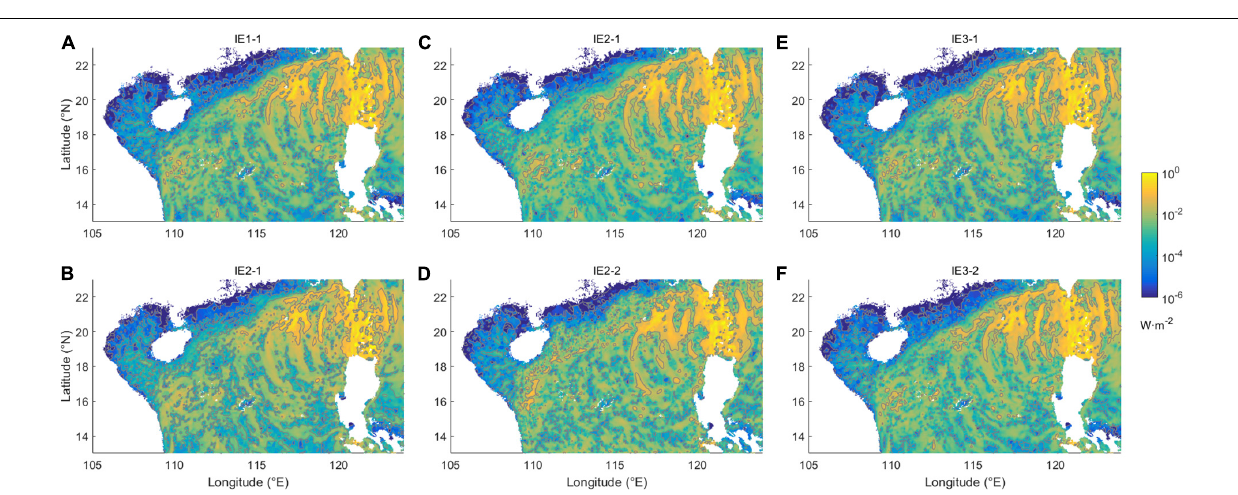
Frontiers in Marine Science |